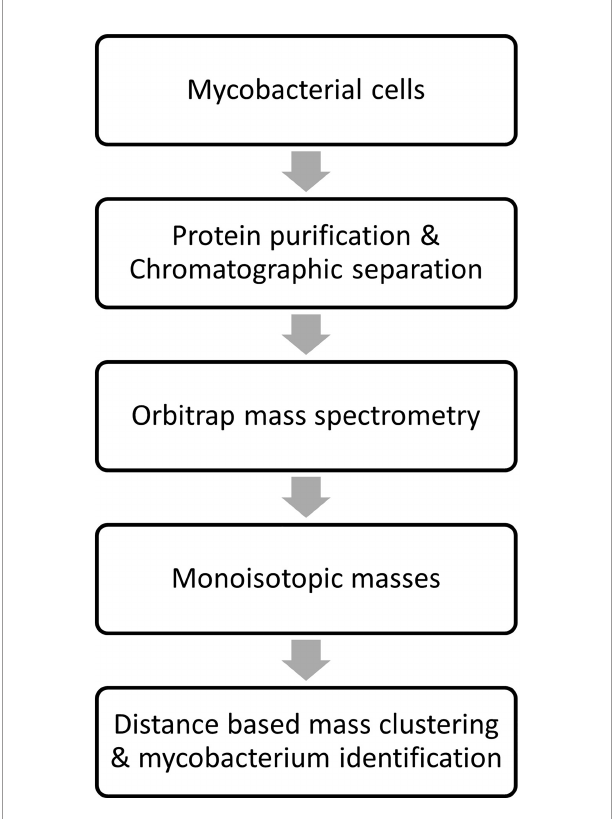
FIGURE 3 | Overview of sample processing, data acquisition and analysis steps employed in stepwise analysis of LC-MS Orbitrap